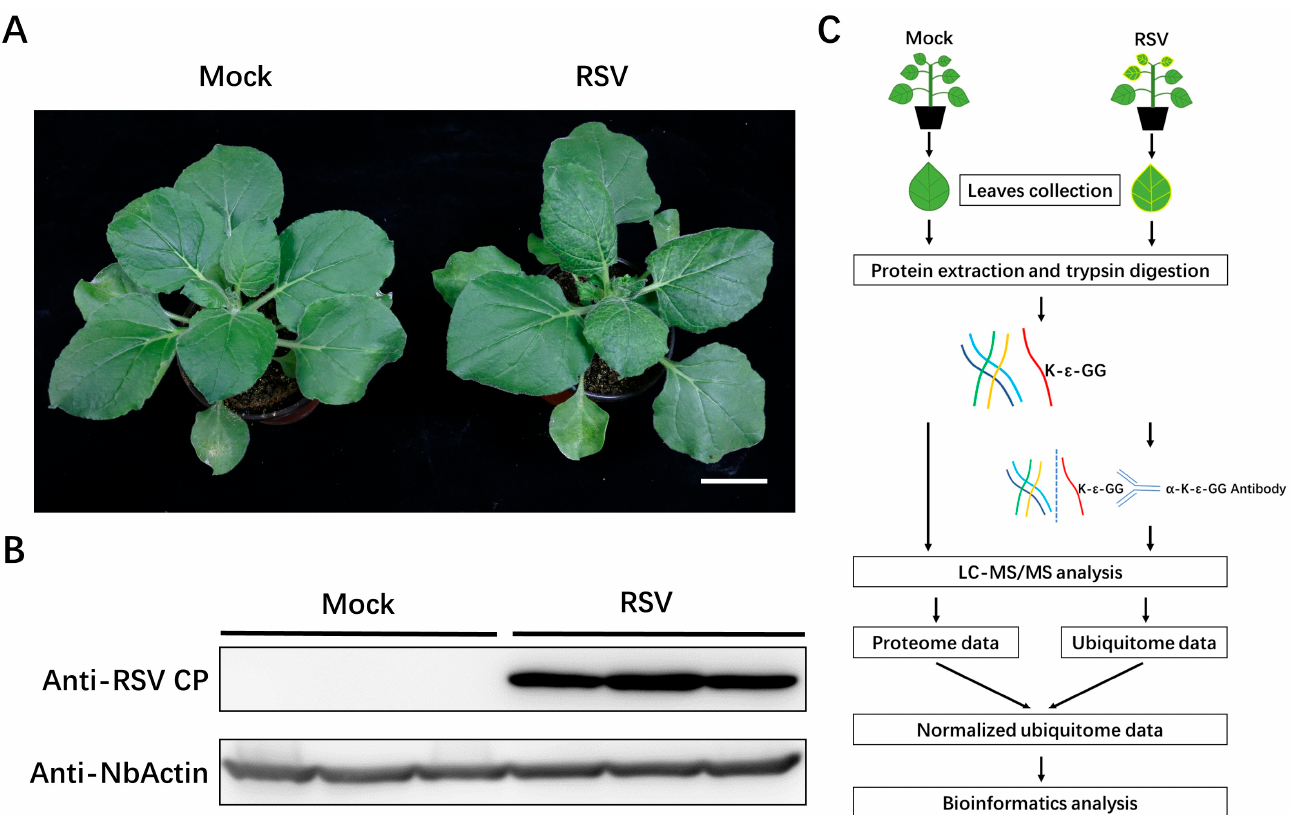
Figure 1. Virus infection and experimental design. ( A ) N. benthamiana inoculated with RSV infected rice sap or with healthy rice sap (mock) at 10 dpi. Bar, 3 cm. ( B ) Western blot showing the effective infection of RSV. NbActin was used as a loading control. ( C ) A workflow diagram for the identification and relative quantification of Kub sites in RSV infected or mock N. benthamiana .